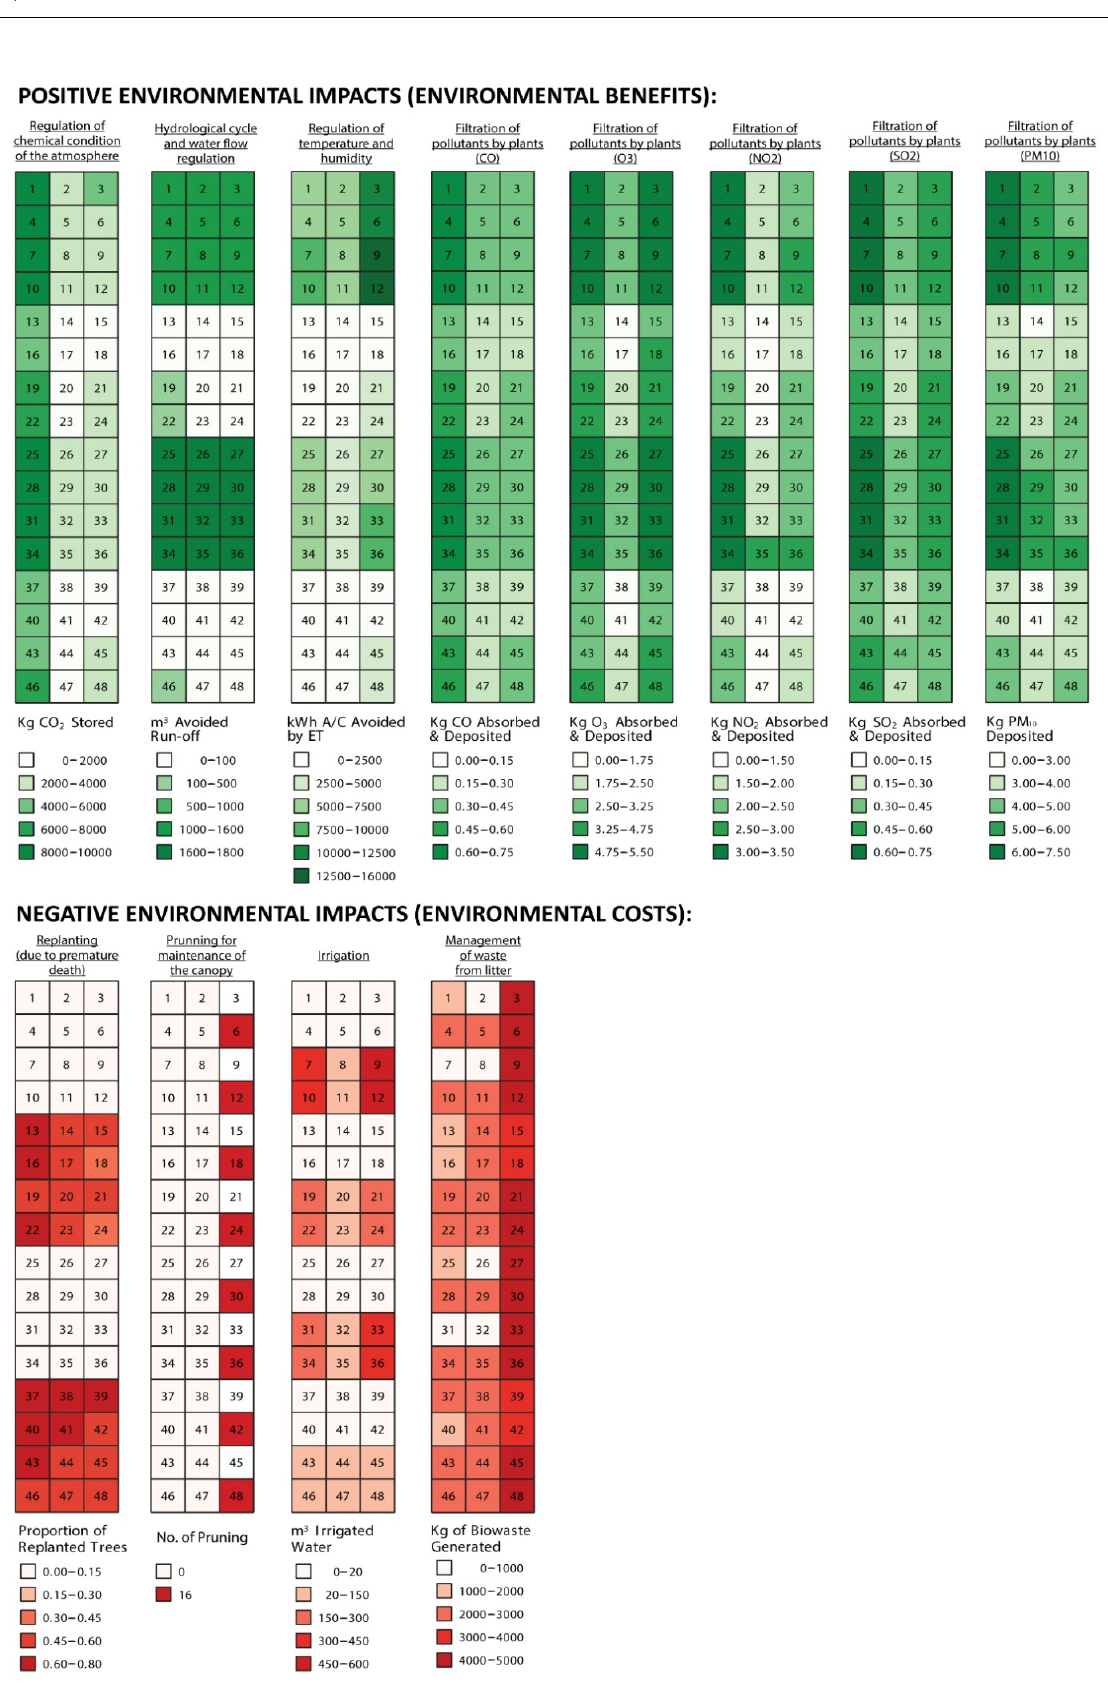
Figure 9. Mean cumulative benefits and costs over the operational stage of the 48 urban forest archetypes in biophysical units.